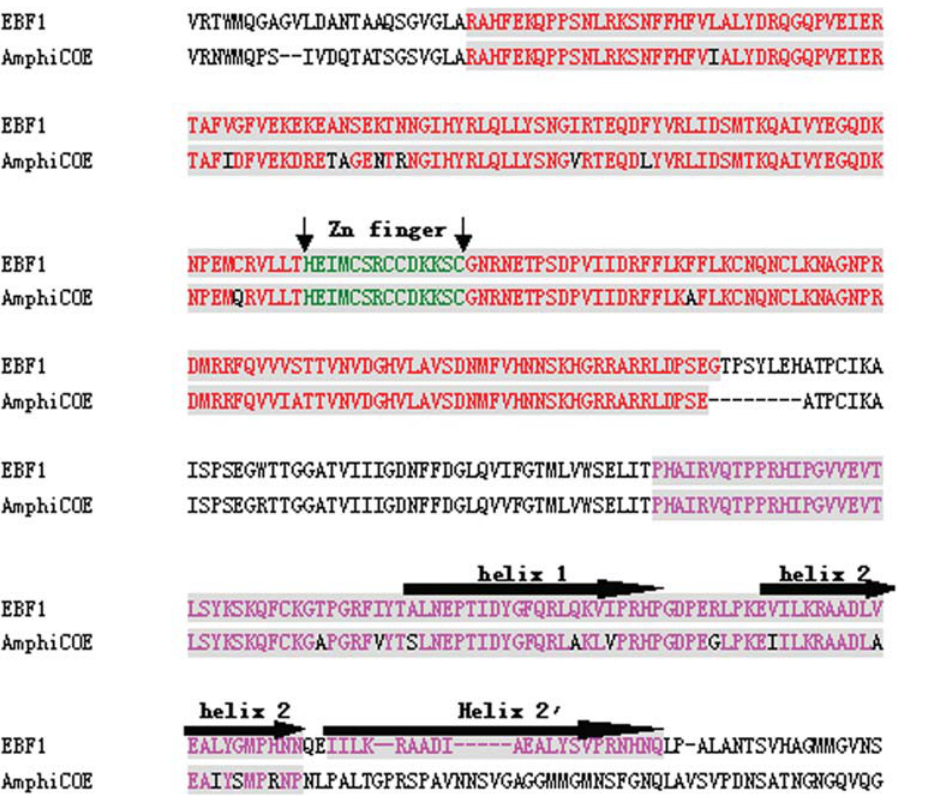
Figure 7. Alignment of Mus EBF1 and amphioxus EBF protein sequence. The conserved DNA binding domain and IPT/TIG domain were colored with red and orange separately. The atypical zinc finger motif obligatory for DNA binding was marked with black arrows. The horizontal dashed arrow indicated the helix 1 and helix 2 of HLH motif. The additional duplicated helix 2 in vertebrate COE proteins was also indicated. The accession number of Mus EBF-1 is